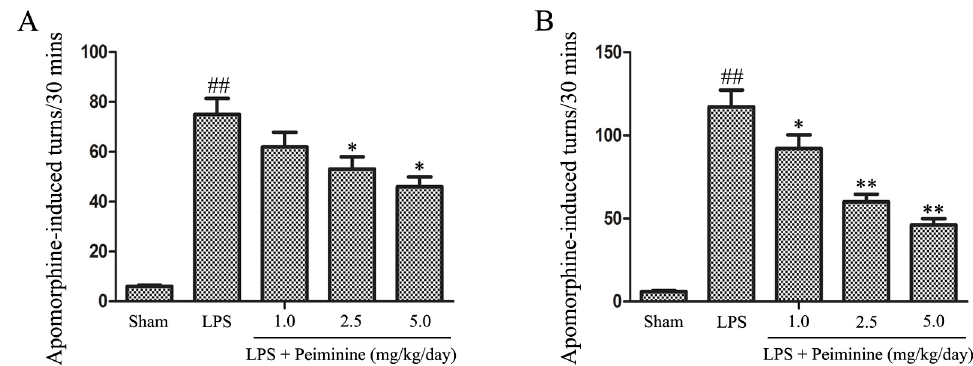
Figure 1. Peiminine improves LPS-induced motor dysfunction. Rats were pretreated with peiminine (1.0, 2.5 or 5.0 mg/kg/day) for three days prior to the intranigral injection of LPS for 28 days. The number of turns induced by apomorphine after two weeks ( A ) and four weeks ( B ) in the LPS-induced PD rat model is shown ( n = 8 rats per group). ## p < 0.01 compared to the sham group, * p < 0.05 and ** p < 0.01 compared to the LPS